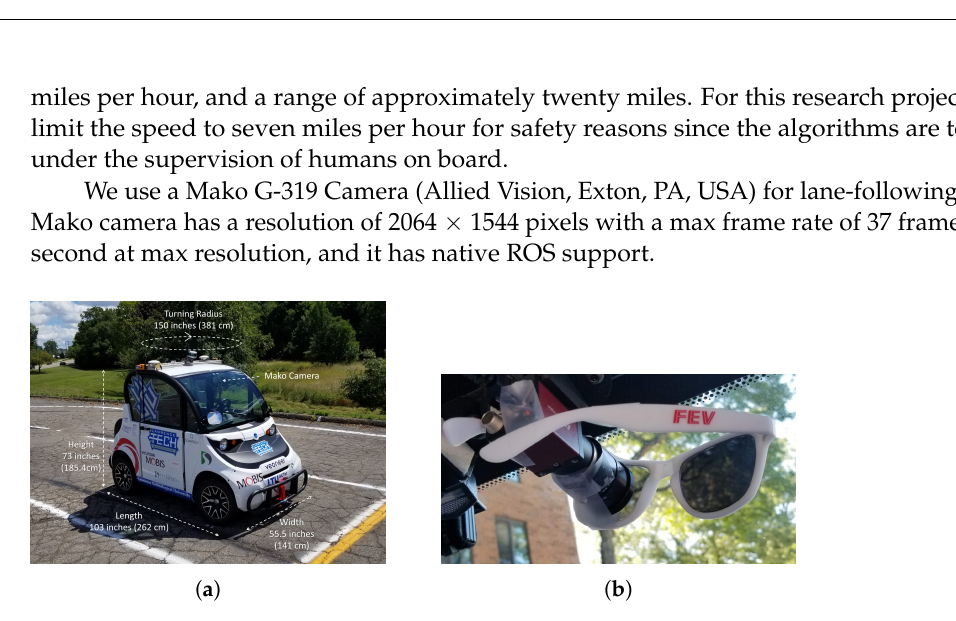
Figure 3. The above images contain details about the vehicle: ( a ) ACTor Specifications. The width of the vehicle is 55.5 inches (141 cm) and length is 103 inches (262 cm) as labelled above; ( b ) The camera of the vehicle is fitted with sunglasses to reduce bright reflection and unwanted glare.